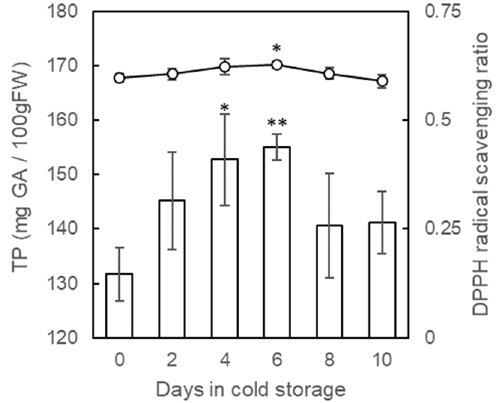
Figure 4. Relationship between total polyphenol contents and antioxidant activity (DPPH radical scavenging ratio) of strawberry fruits during cold storage. Total polyphenol contents and DPPH radical scavenging ratio are represented by bar and line graph, respectively. Harvested strawberry fruits were stored at 0 °C for 10 days with porous film bag. The vertical bar indicates a standard error of six replicates. Asterisks indicate significant differences in comparison to control (0 day) at p = 0.05 * or 0.01 ** with Wilcoxon test.